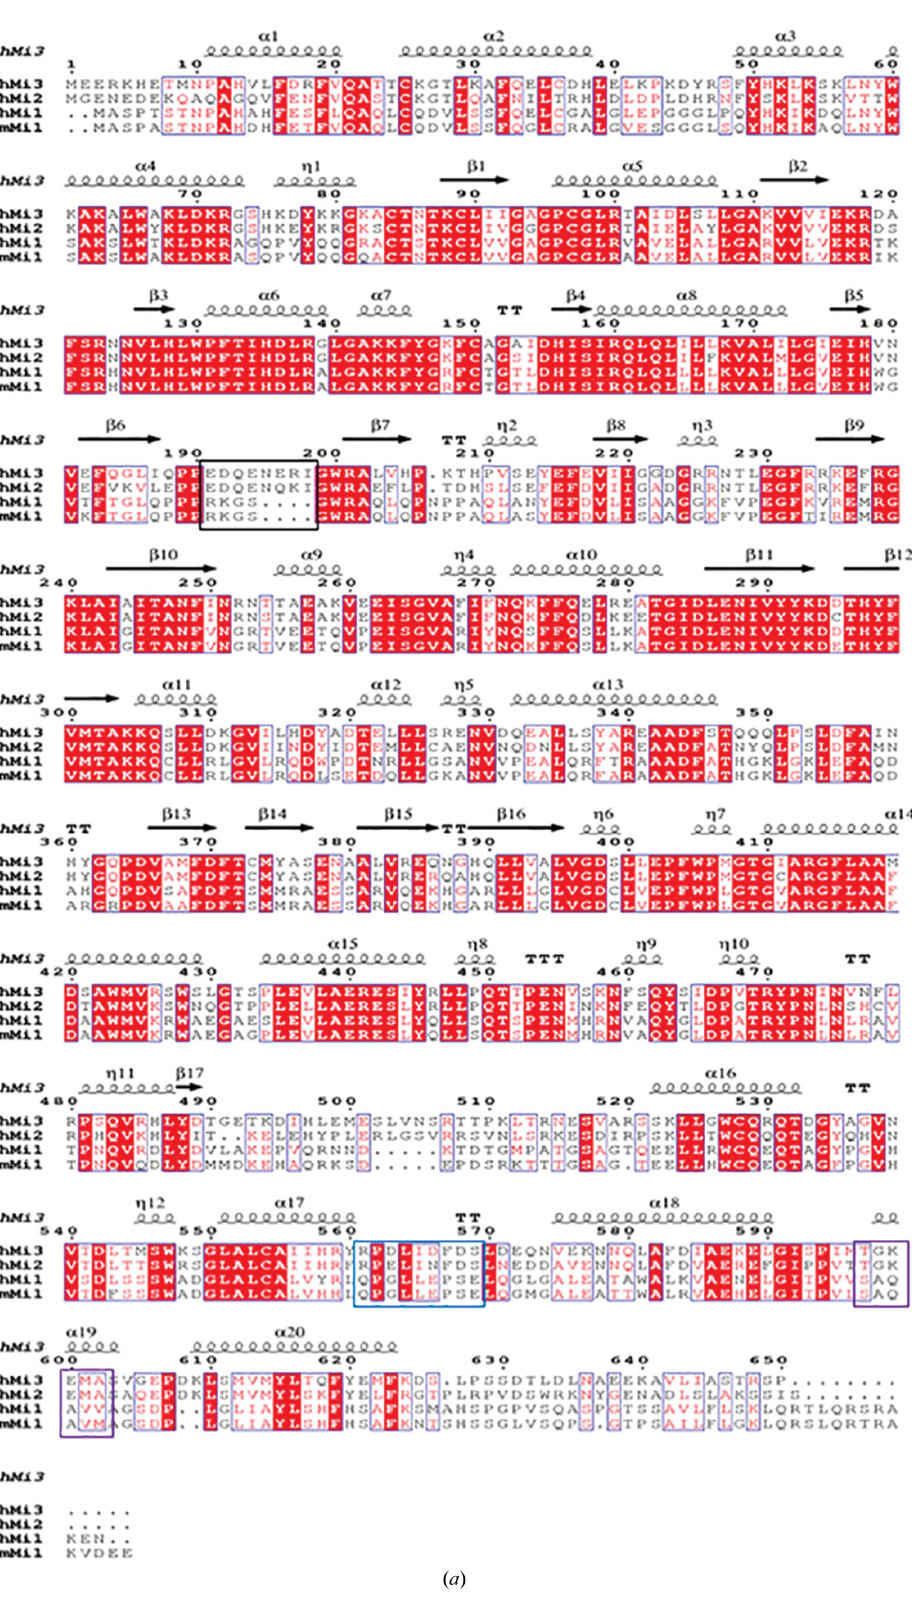
Figure 1 Overall structure and characterization of human MICAL3 FMOCH . ( a ) Sequence alignment of human MICAL3, human MICAL2, human MICAL1 and mouse MICAL1. Strictly conserved residues are boxed in red, while similar residues are shown as red letters. The sequence-alignment tools used were ClustalW and ESPript . 3 10 -Helices are represented by (cid:3) , strict (cid:2) -turns are represented by TT and strict (cid:4) -turns by TTT